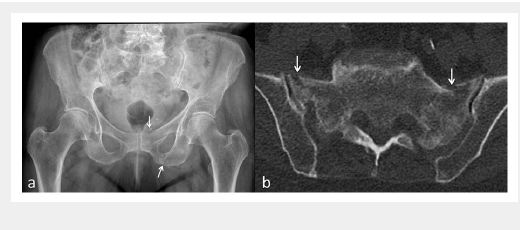
a) Difficult assessment of the posterior pelvic ring on standard x-ray. b) CT-scan of the same patient reveals bilateral fracture of the lateral mass of the